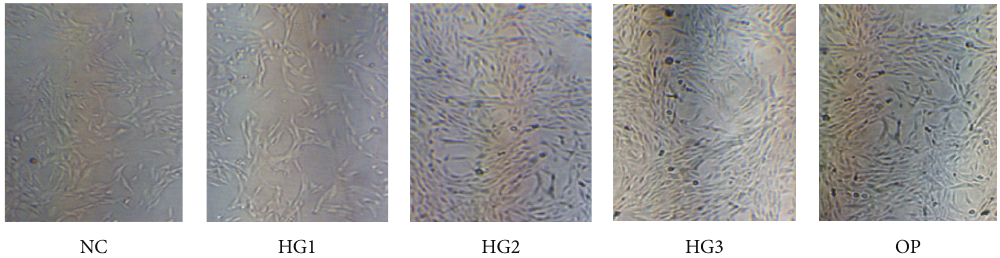
Figure 1: Cell picture in each group of GMCs by inverted phase contrast microscope ( × 100). No significant changes in cell morphology.